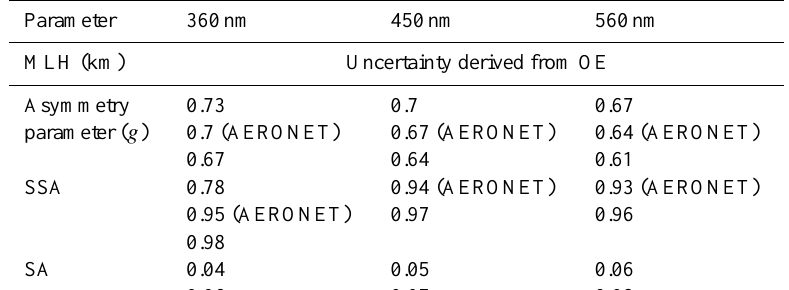
Table 5. Sensitivity studies for the correction factor.